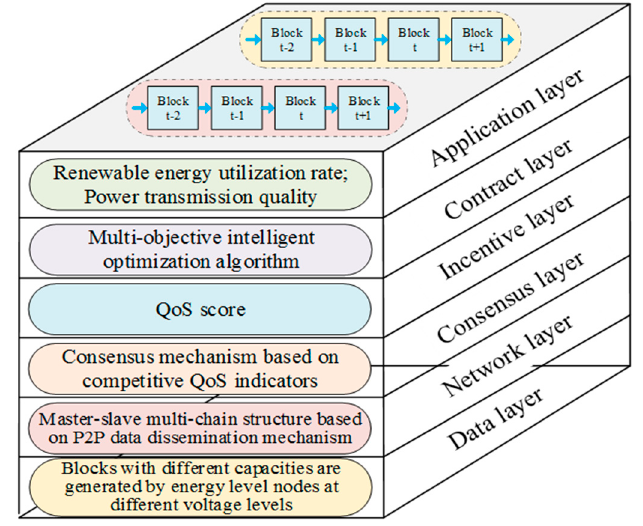
Figure 3. Node model of transmission and distribution network energy router.